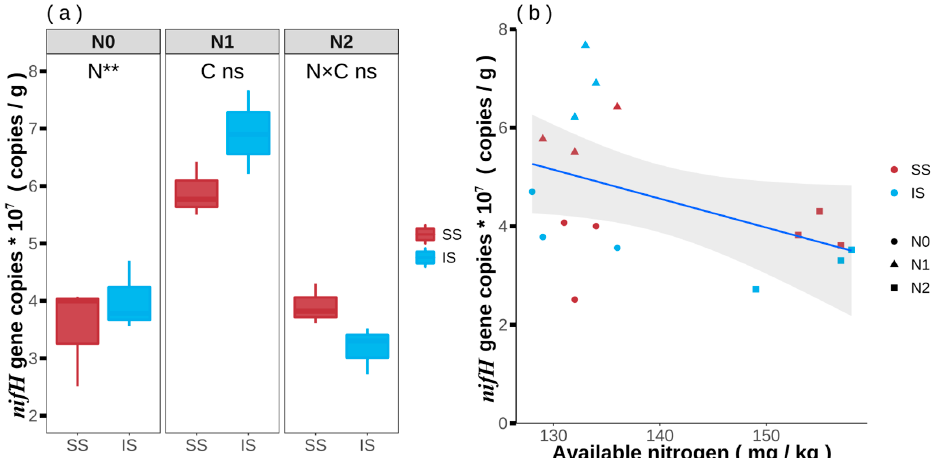
Figure 5. The nifH gene copies in soybean rhizosphere soil with di ff erent nitrogen levels (×10 7 ) ( a ) and their correlation with soil available nitrogen ( b ) with di ff erent nitrogen application rates. N indicates nitrogen application rates; C indicates planting pa tt erns; N×C shows the interaction between nitrogen application rates and planting pa tt erns by two ways ANOVA. ns and **, respectively, indicate that the di ff erence is not signi fi cant, and di ff erence is signi fi cant at levels of p < 0.01. Data are presented as a Mean ± SD ( n = 3).